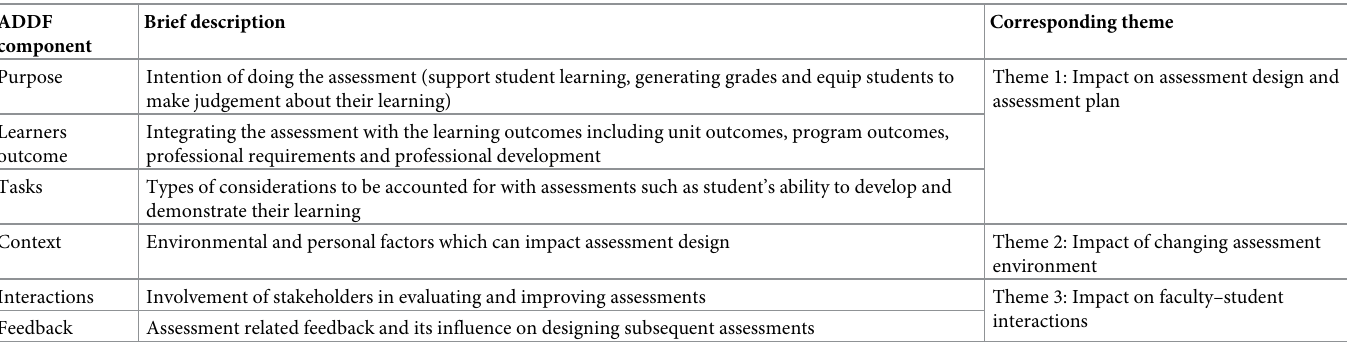
Table 1. ADDF components and corresponding study